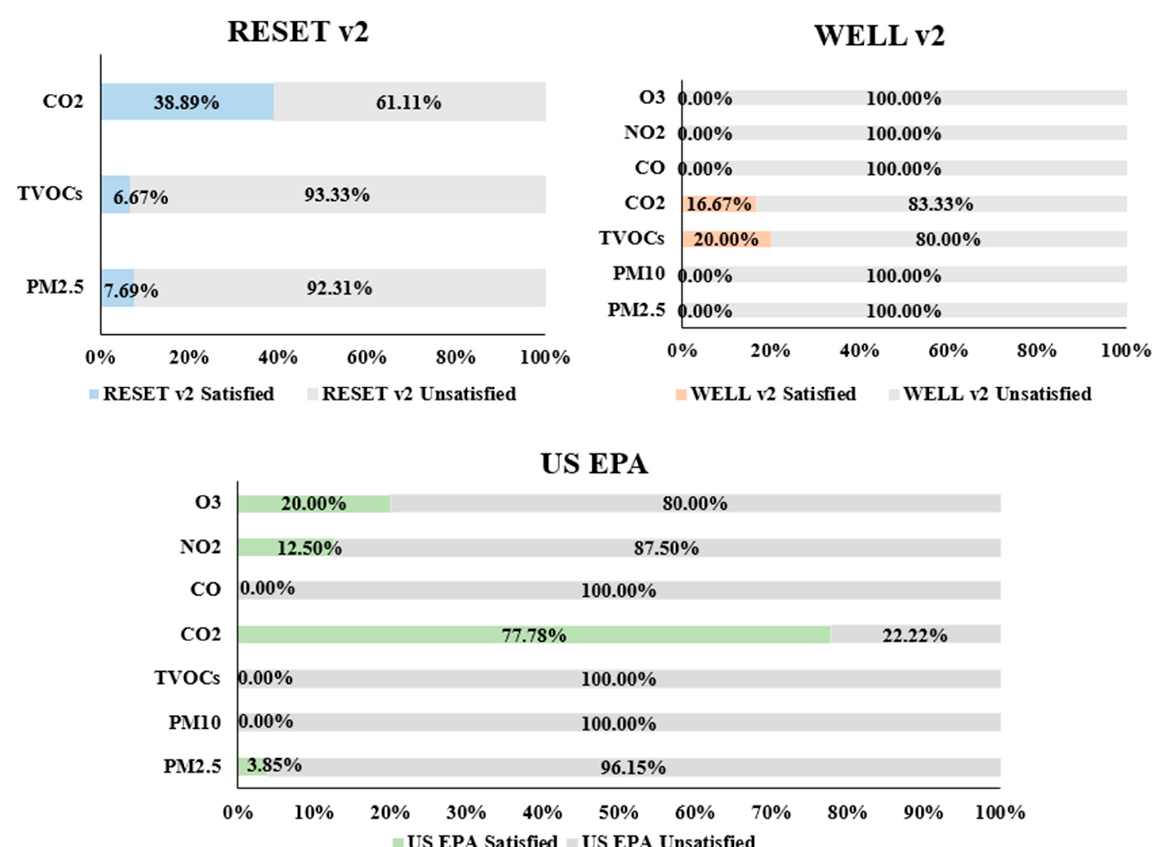
Figure 3. Sensor modules of various IAQ pollutants and sensing requirements. Note: CO2 and CO 2 , PM2.5 and PM 2.5 , PM10 and PM 10 , NO2 and NO 2 , and O3 and O 3 are used interchangeably.